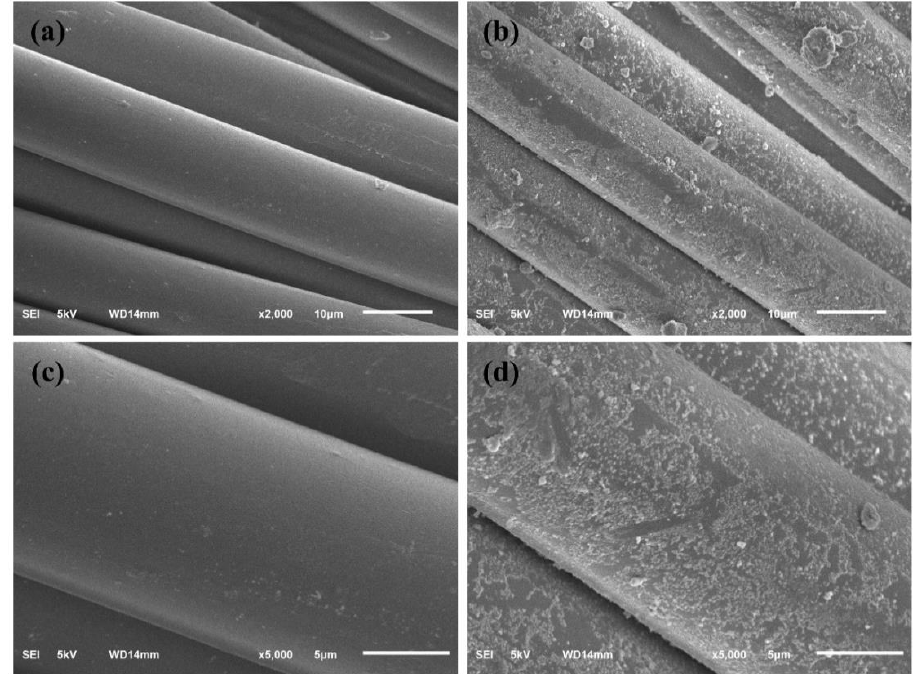
Figure 5. Scanning electron micrograph of photocatalytic materials ( a ) polyester fabric (×2000), ( b ) Y 2 O 3 /TiO 2 loaded polyester fabric (×2000), ( c ) polyester fabric (×5000), ( d ) Y 2 O 3 /TiO 2 -loaded polyester fabric (×5000).